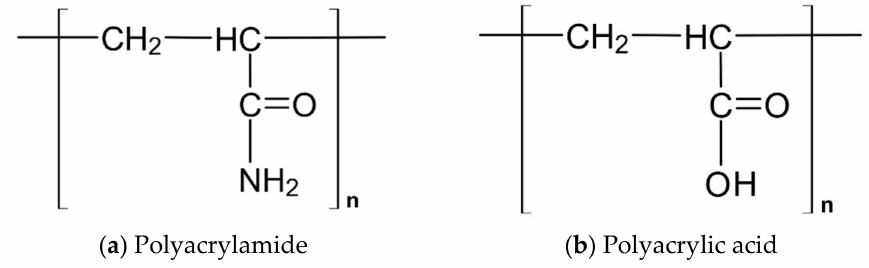
Figure 2. Base of superabsorbent polymers: acrylamide ( a ) and acrylic acid ( b